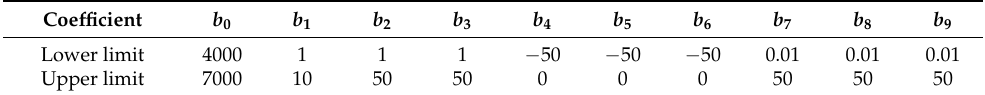
Table 4. The upper and lower limits of each